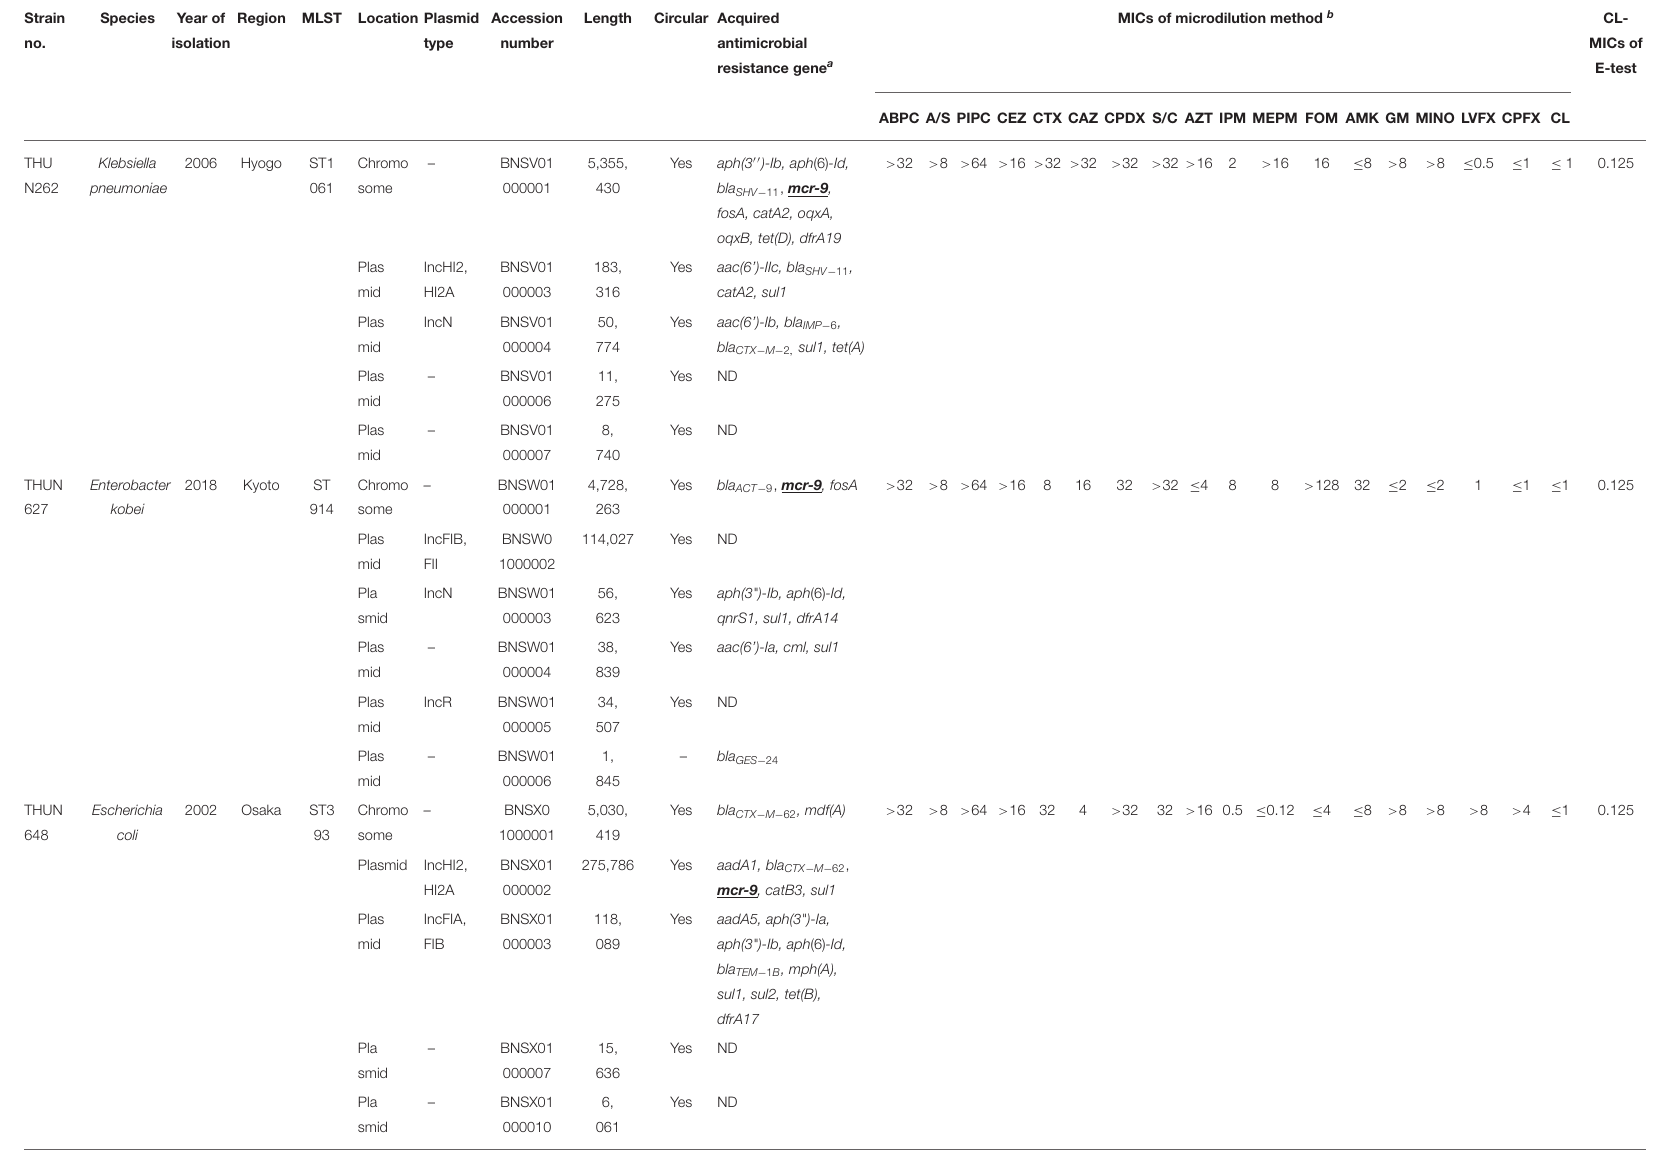
TABLE 3 | Genetic characterization of three strains with mcr-9 and MICs using microdilution method and E -test. Strain